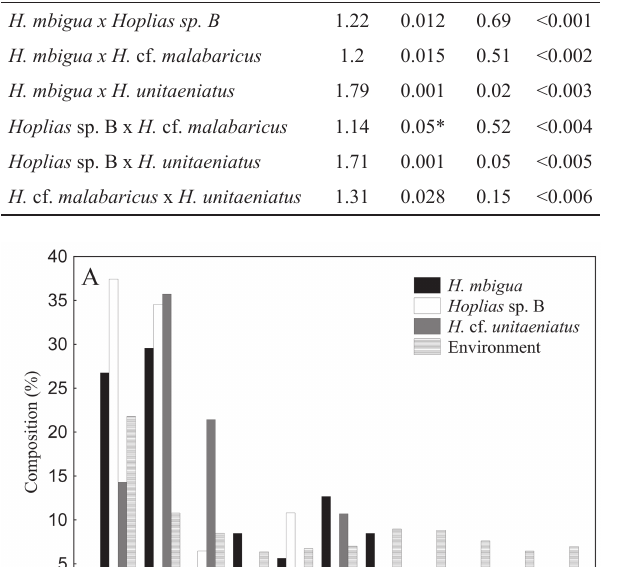
Fig. 3. A- Relative composition of prey species sizes in the diets of non-native ( H. mbigua ) and native ( Hoplias sp. B and H. cf. malabaricus ) Erythrinidae species in the upper Paraná River floodplain and relative abundance in the environment during the sampling period in the upper Paraná River floodplain. B - Feeding selectivity ( E mbigua (non-native), Hoplias sp. B and H. cf. malabaricus (native) for different prey size classes (mm). The non-native H. unitaeniatus is not present due to the low representation of fish in its